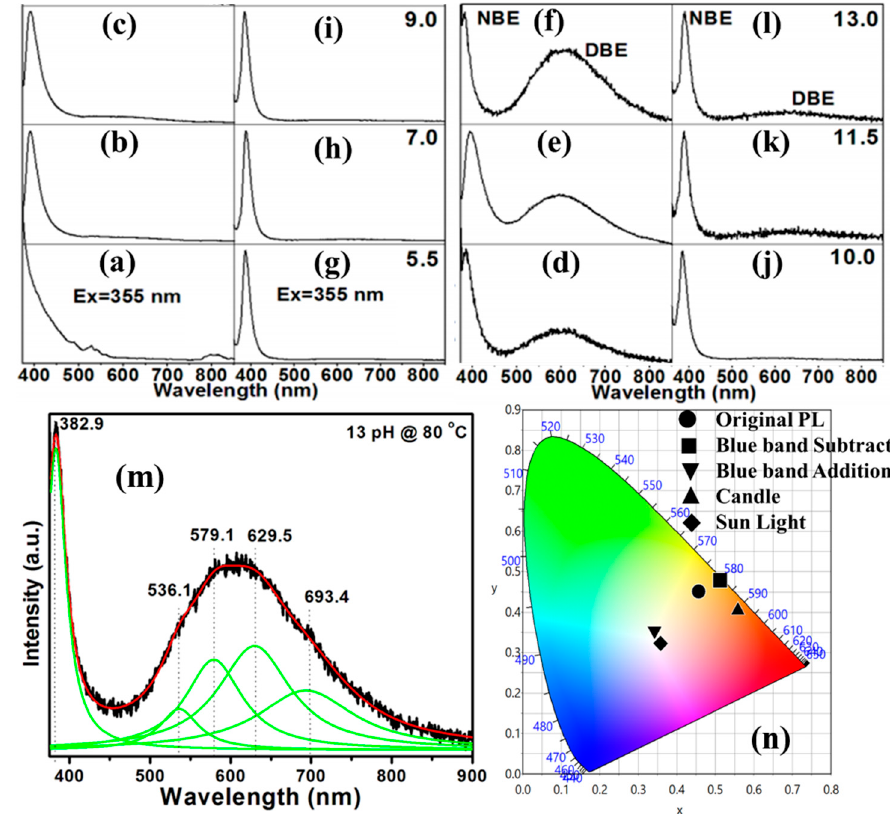
Figure 6. Photoluminescence (PL) spectrum for synthesized ZnO powder: ( a )–( f ) for pH 5.5, 7, 9, 10, 11.5, and 13.0, respectively dried at 80 °C for 24 h; ( g )–( l ) for pH 5.5, 7, 9, 10, 11.5, and 13.0, respectively dried at 250 °C for 5 h; ( m ) deconvoluted PL spectra of sample synthesized at pH 13 and dried at 80 °C for 24 h; ( n ) simulated PL spectra of pH 13 and dried at 80 °C for 24 h along with the possibility of application for achieving the candle-like and sun equivalent spectra.